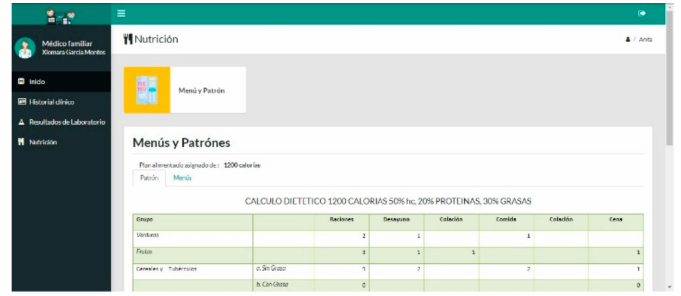
Figure 26. Physician application interface: Eating pattern assigned to the patient.